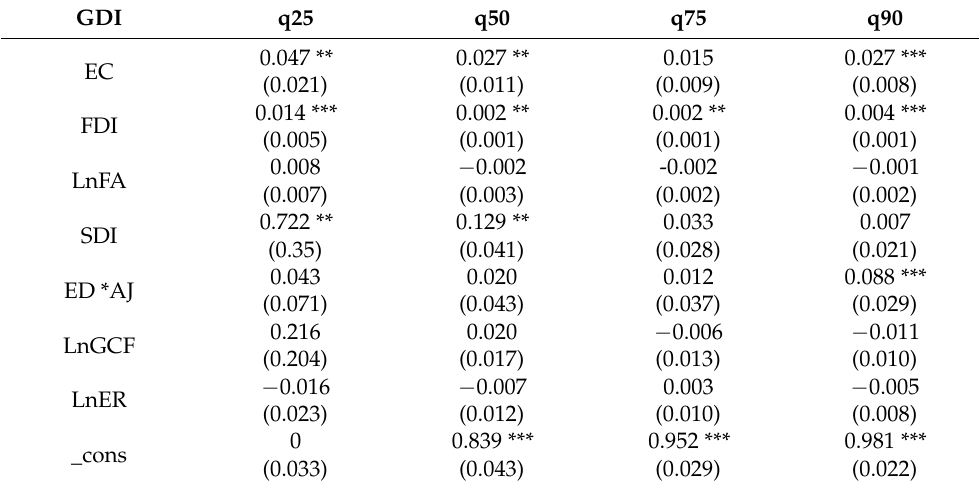
Table 4. Results of Generalised Quantile Regression 2000–2020. Dependent variable: Gender Devel- opment Index (United Nations Reports). 24 Asian